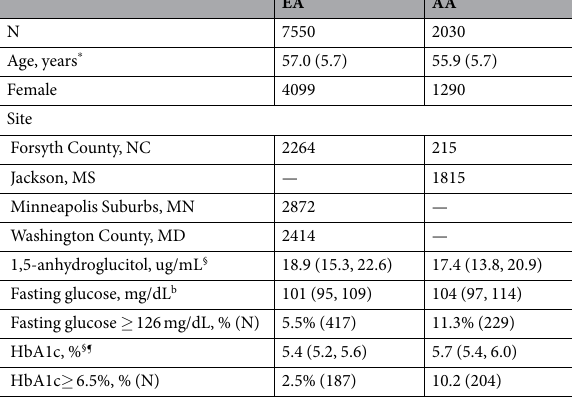
Table 1. Characteristics of ARIC study participants included in present genetic study. * Mean (standard deviation). § Median (interquartile range: 25 th percentile, 75 th percentile). ¶ 82 EA and 39 AA participants were missing hemoglobin A1c (%)